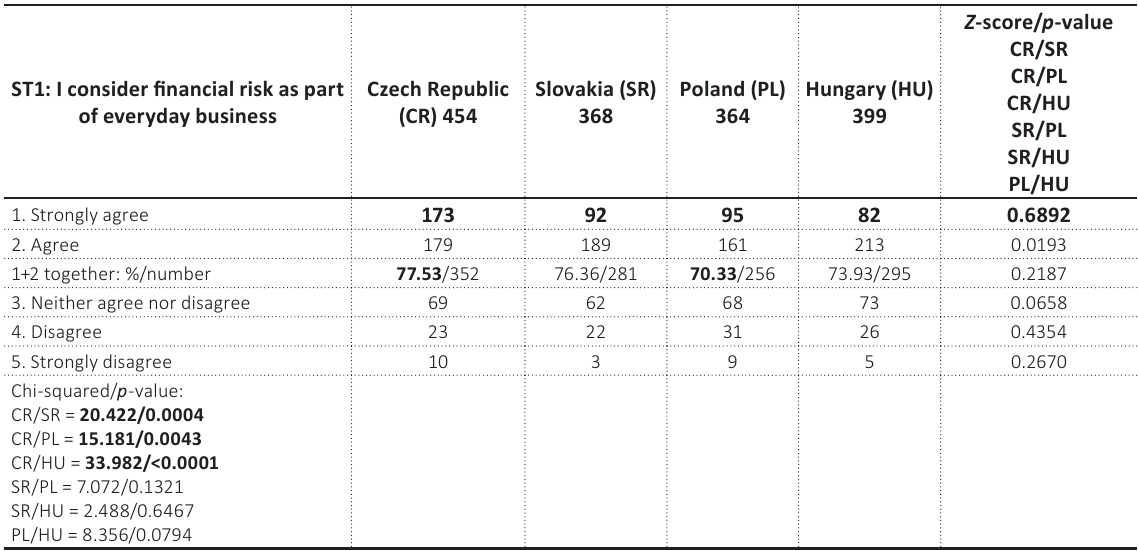
Table 1. Evaluation of financial risk in the V4